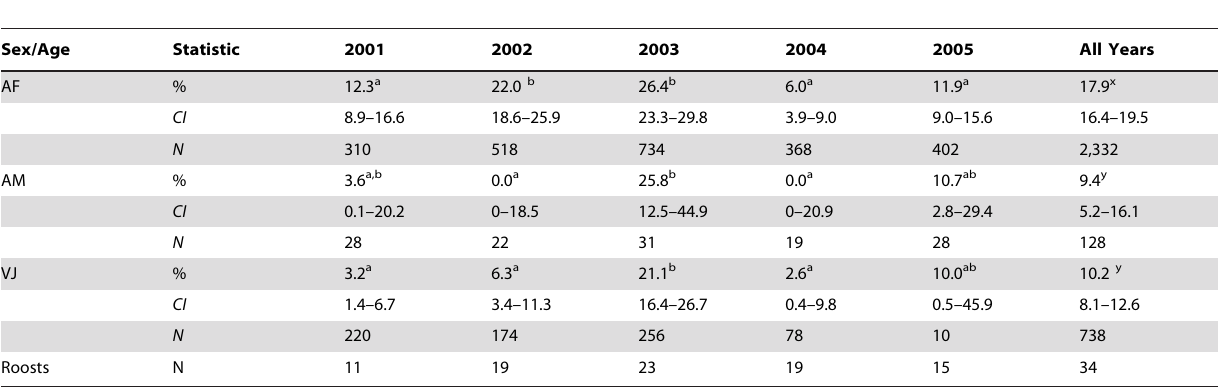
Table 2. Cross-sectional summaries of seroprevalence of RVNA by age class and sex in individual big brown bats ( Eptesicus fuscus ) by year, Fort Collins, Colorado, 2001–2005, all roosts